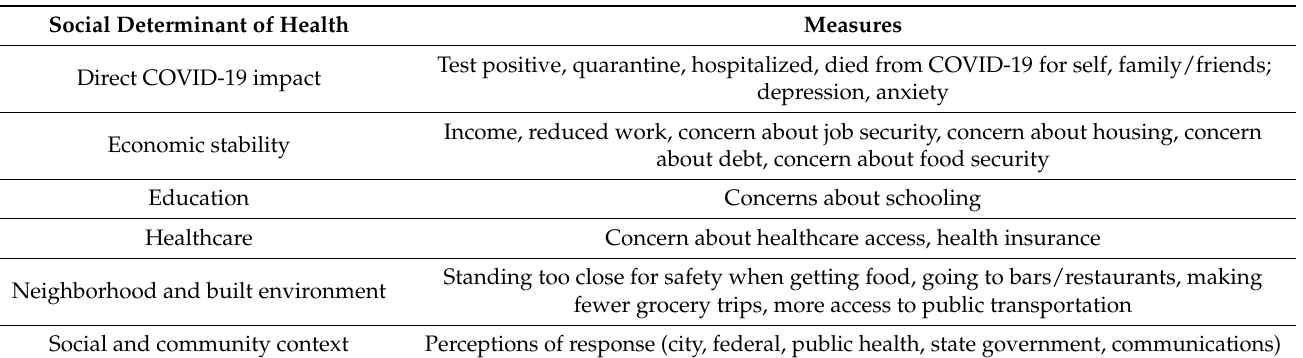
Table 1. Social determinants of health domains aligned with survey